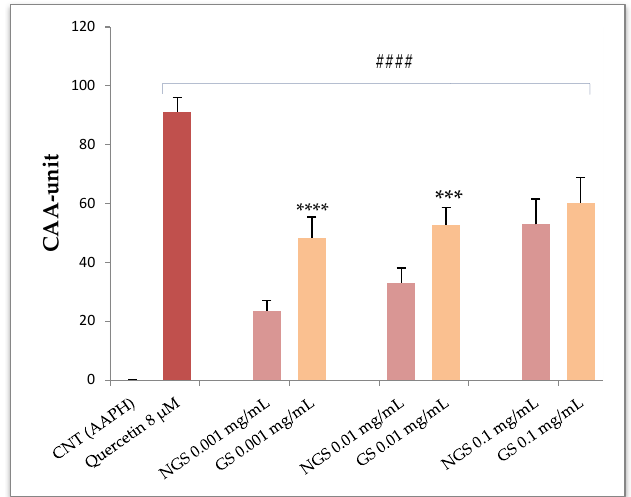
Figure 1. Effects of increasing doses (0.001, 0.01, and 0.1 mg/mL) of non-germinated (NGS) and germinated (GS) sorghum extracts on the cellular antioxidant activity of human red blood cells (RBCs) exposed to oxidative stress. Quercetin was used as a standard. Results were derived from five distinct healthy volunteers blood samples ( n = 5) and expressed as mean ± SD. # Significantly different from control (CNT), #### p < 0.0001. * Significantly different from the co-respective NGS: *** p < 0.001, **** p < 0.0001.